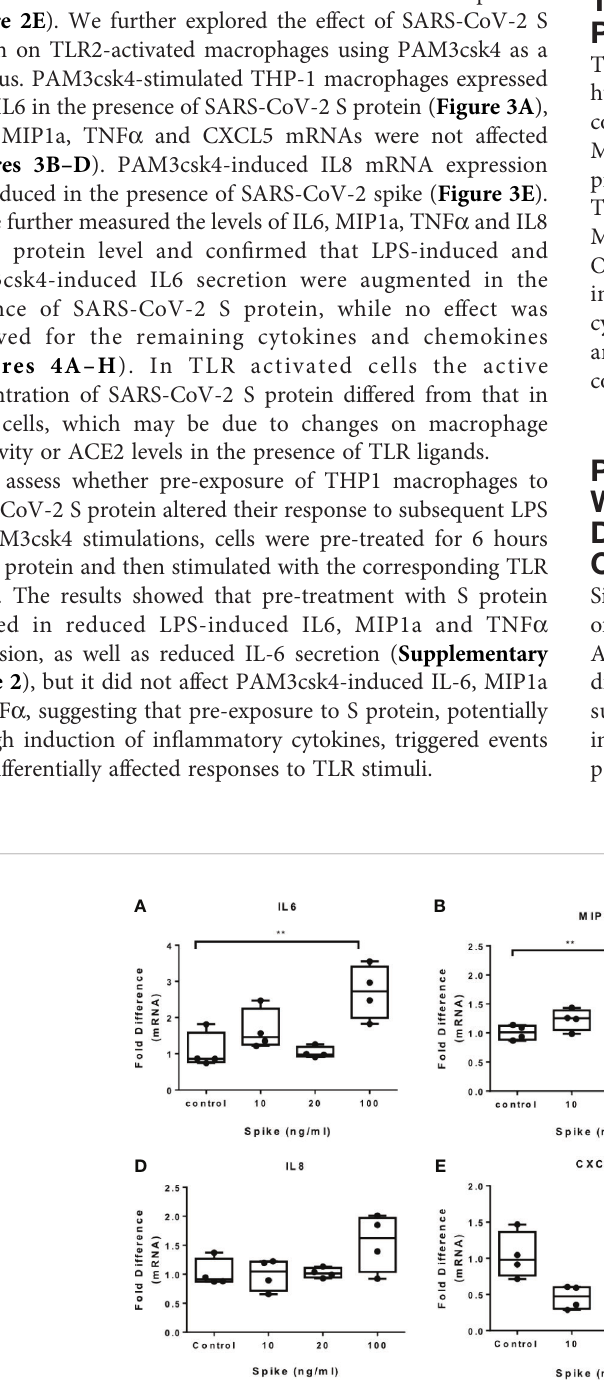
FIGURE 2 | SARS-CoV-2 S protein increased cytokine expression in LPS-induced THP-1 macrophages. THP-1 macrophages were treated with various concentrations of SARS-CoV-2 Spike-Membrane recombinant fusion protein and LPS (100ng/ml) for 12 hours. (A – E) LPS-induced IL6, MIP1a, TNF a , IL8 and CXCL5 expression was measured. Data are illustrated in box-and-whiskers and plotted as median (± min, max). Statistical analysis was performed with Kruskal - Wallis test. *p < 0.05, **p <